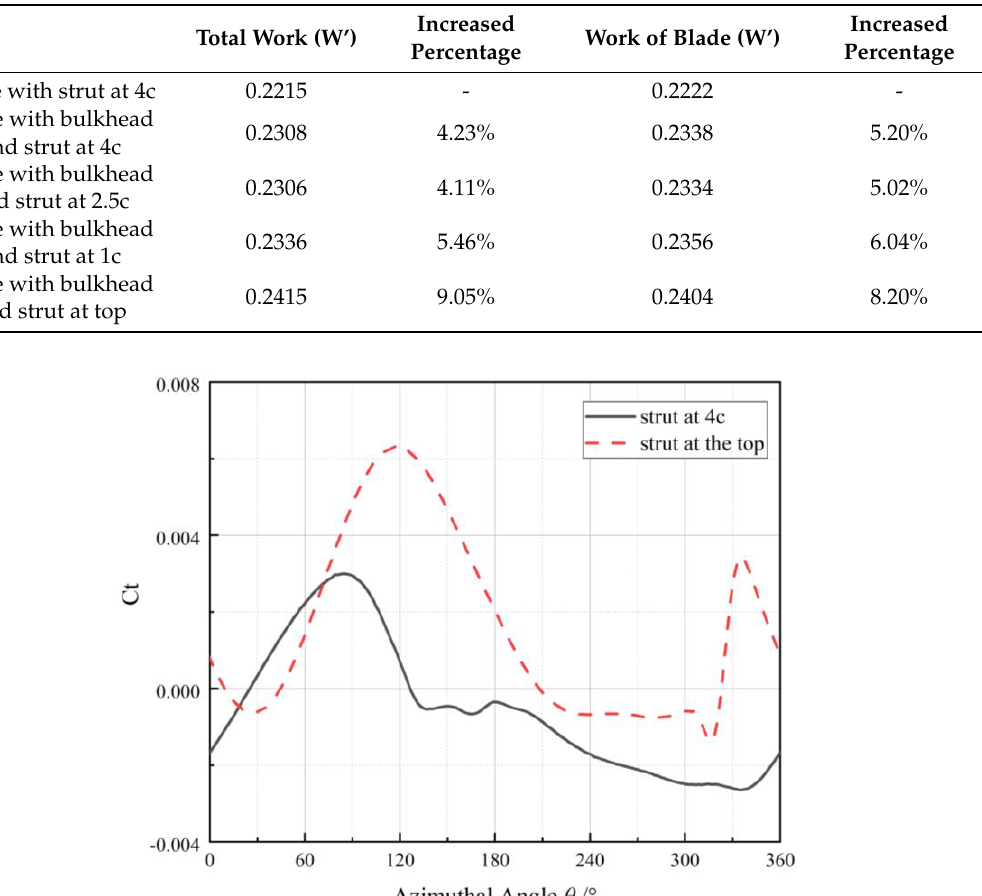
Table 3. Total work and work of the blade with a strut at di ff erent heights.